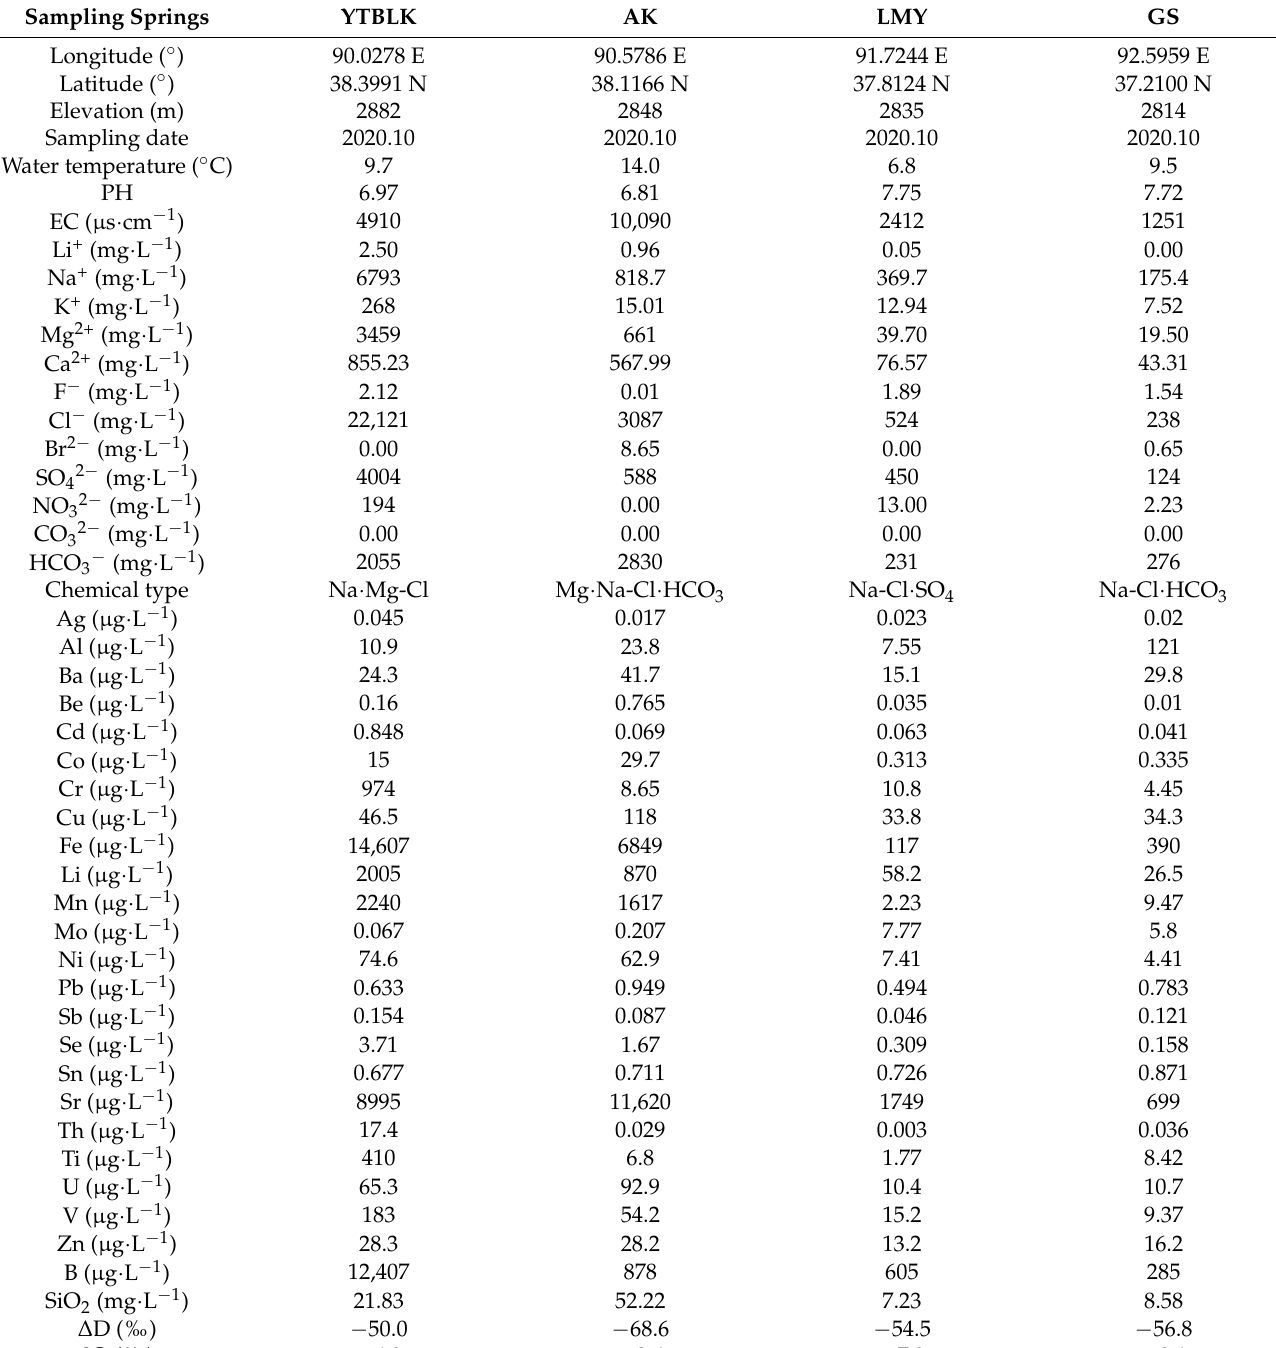
Table 1. Sampling location and time, and physical and chemical composition of water